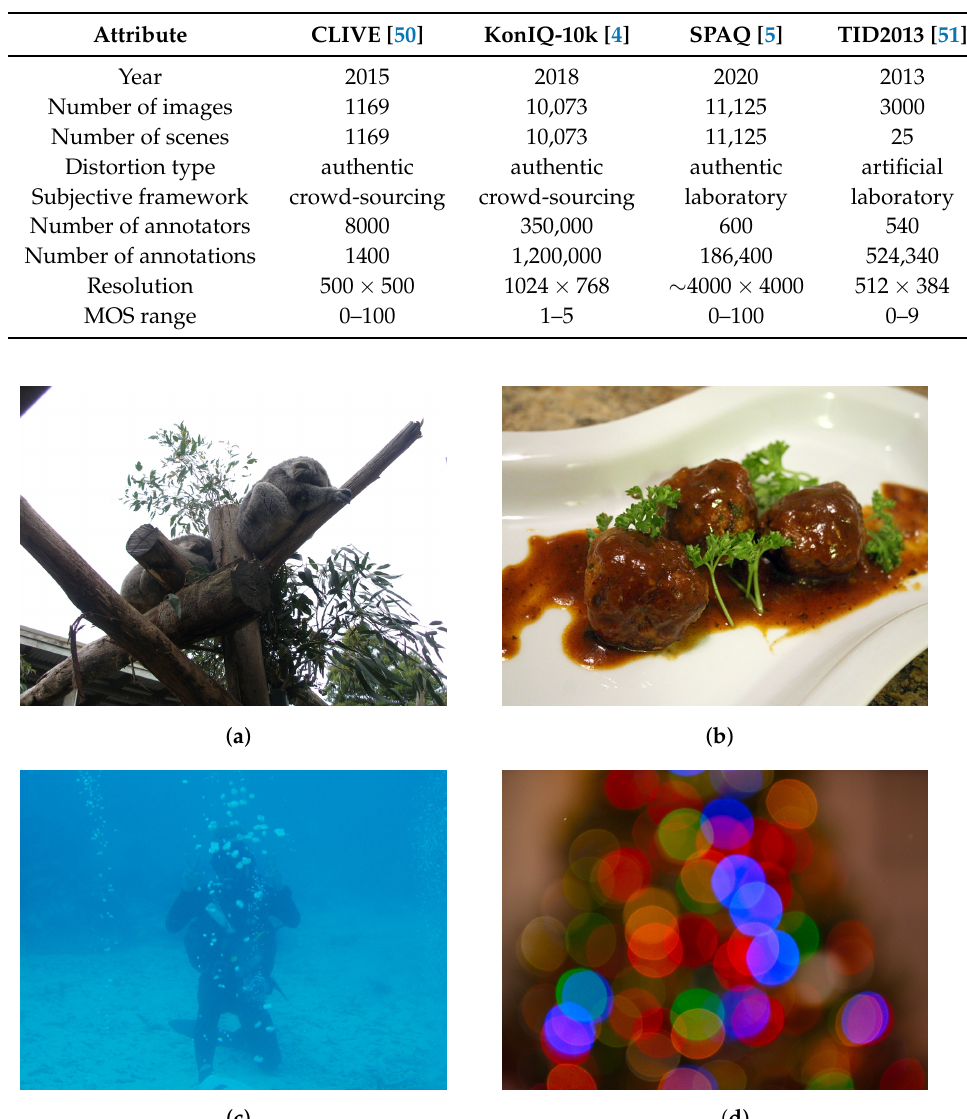
Figure 2. Sample images from KonIQ-10k [4] with their MOS values: a) MOS = 3.4673, b) MOS = 3.6040, c) MOS = 2.2883, d) MOS = 2.1981.